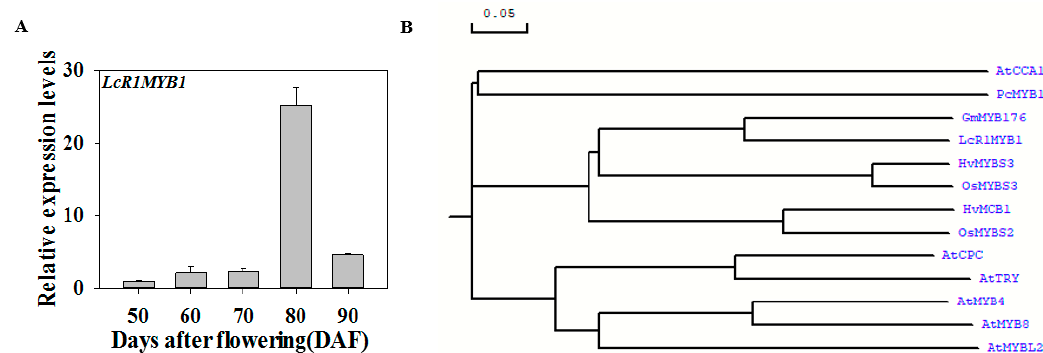
Figure 5. ( A ) Expression of LcR1MYB1 in litchi fruit pericarp during ripening. The expression levels of LcR1MYB1 is expressed as a ratio relative to that at 50 DAF. Each value represents the mean + standard error of three replicates. ( B ) Phylogenetic analysis of LcR1MYB1and R1-MYBs from different species. Phylogenetic tree was constructed was constructed by the neighbor-joining method of DNAMAN6.0. The scale bar represents 0.05 substitutions per site. The amino acid sequences were obtained from NCBI with the accession numbers as below: AtMYBL2 (AEE35154), AtTRY (AED96321), AtCPC